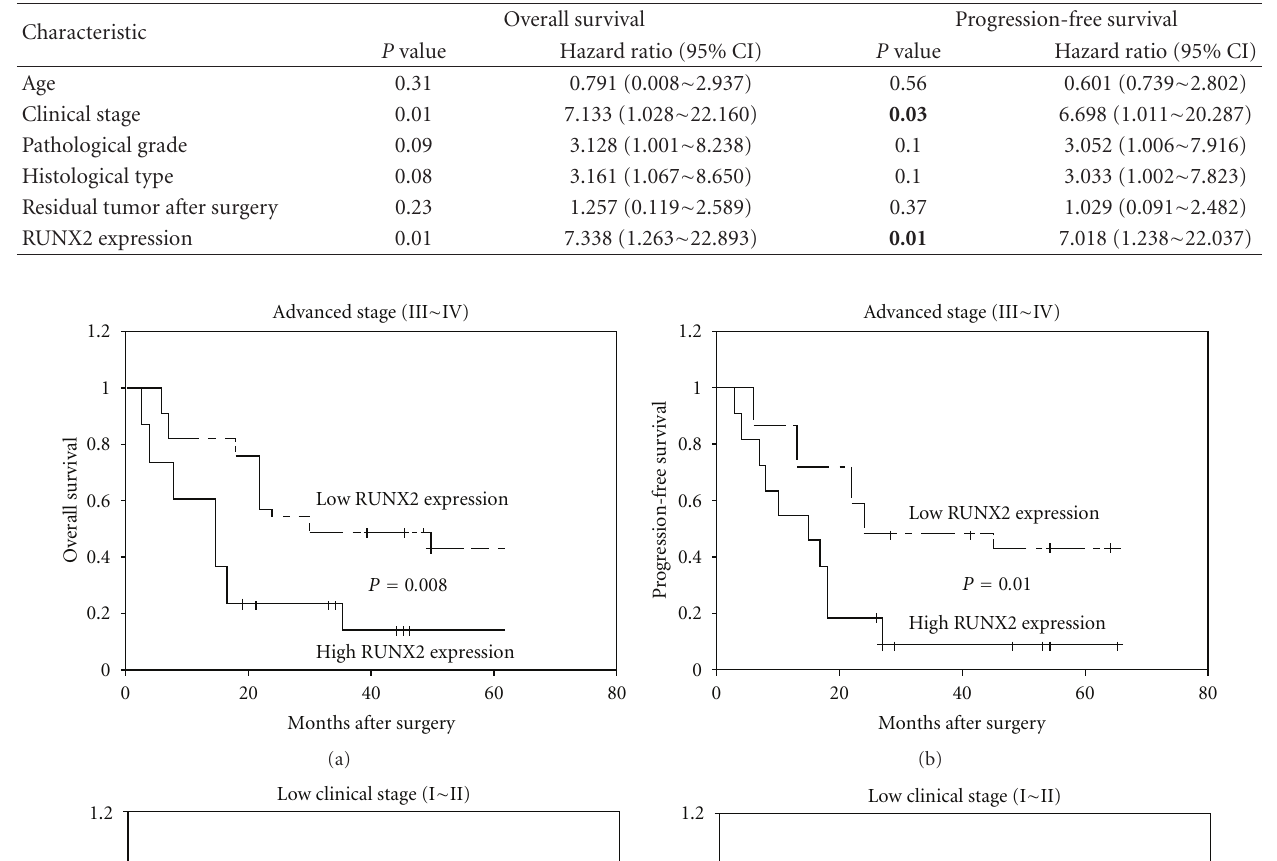
Table 3: Multivariate analysis: factors predicting overall and progression-free survival.